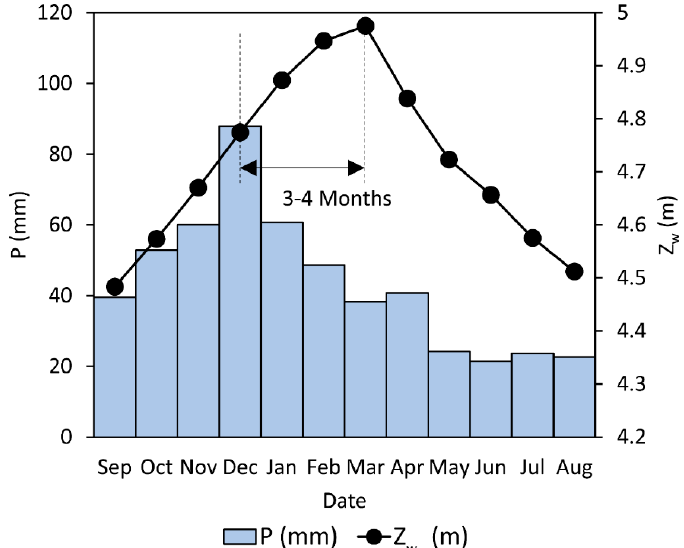
Figure 3. Monthly trends in the period 2002–2012 of rainfall P (mm) and groundwater level Z W (m AMSL) determined on the basis of the time series with time resolution of 20 min derived from the monitoring station of Terra Montonata.